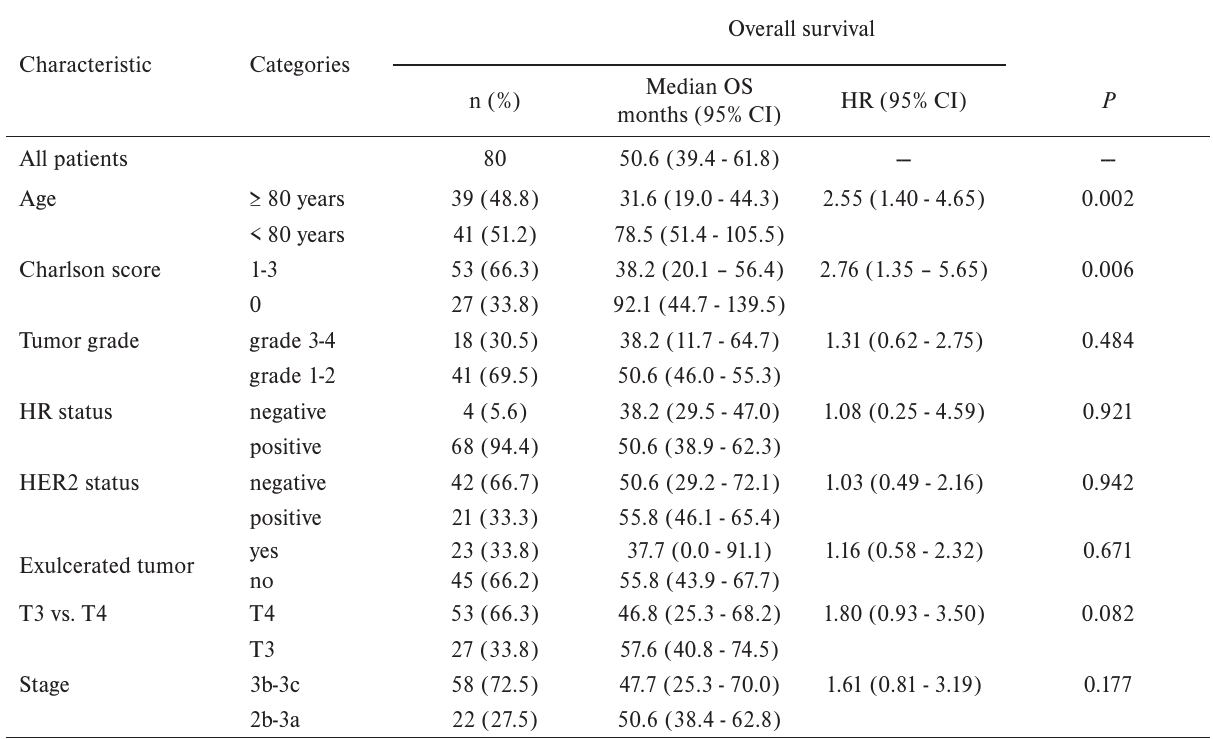
Table 3. Univariate analysis of baseline characteristics predictive for overall survival.